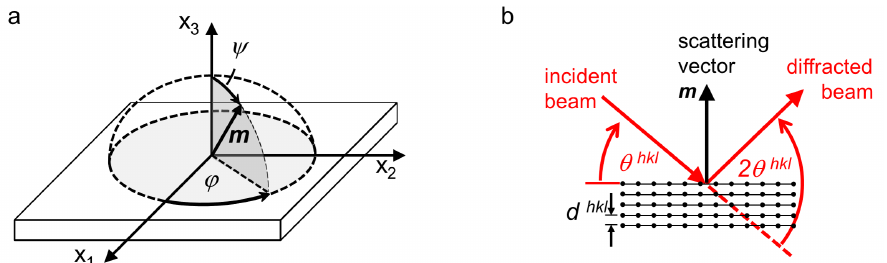
Figure 1. Sample reference system with scattering vector m defined by azimuthal angle ϕ and sample inclination ψ ( a ). Schematic visualisation of the lattice spacing d hkl and diffraction angle θ hkl ( b